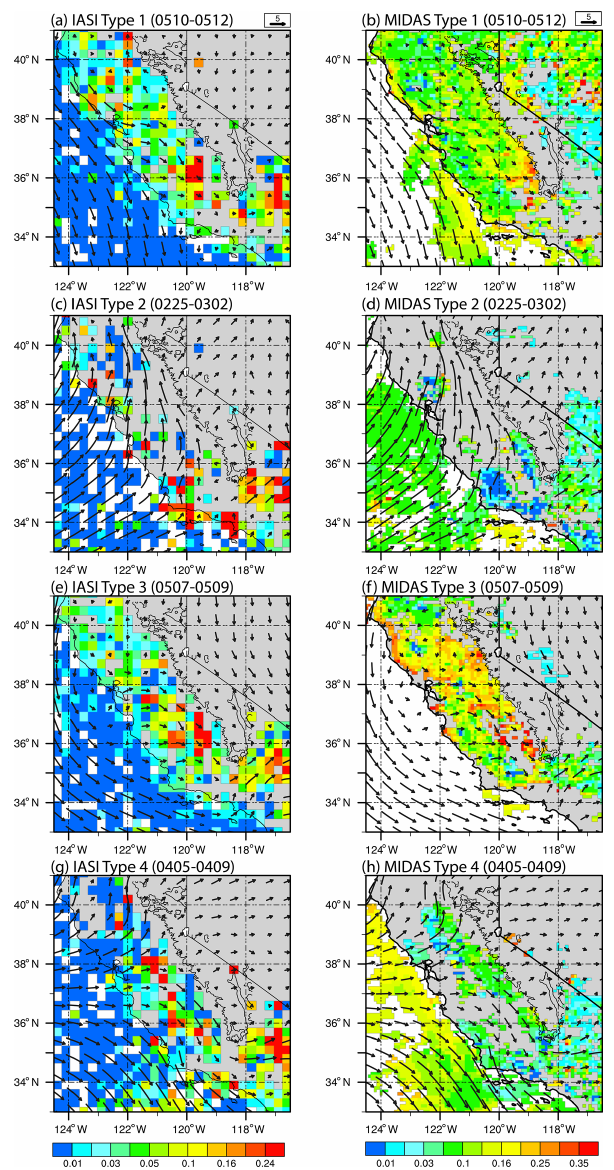
Figure 7. (a, c, e, g) IR DOD at the wavelength of 10µm retrieved from IASI and (b, d, f, h) visible DOD at the wavelength of 550µm from MIDAS for each type. The low-level winds (vectors; ms − 1 ) are obtained from the ERA5 reanalyses. The numbers in the paren- theses indicate the event time period for the year